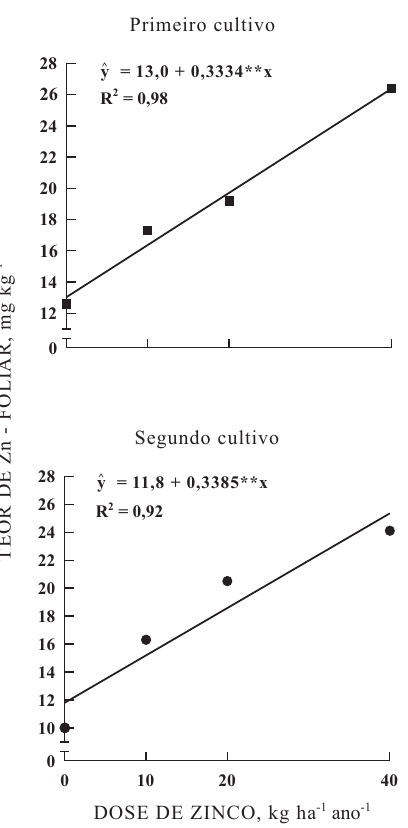
Figura 4. Teor de Zn foliar em função de doses de zinco, via solo, em dois cultivos. (**significativo a 1 % pelo teste de t).